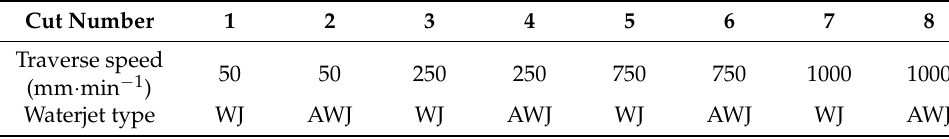
Table 1. Variable technological parameters of the water jet.